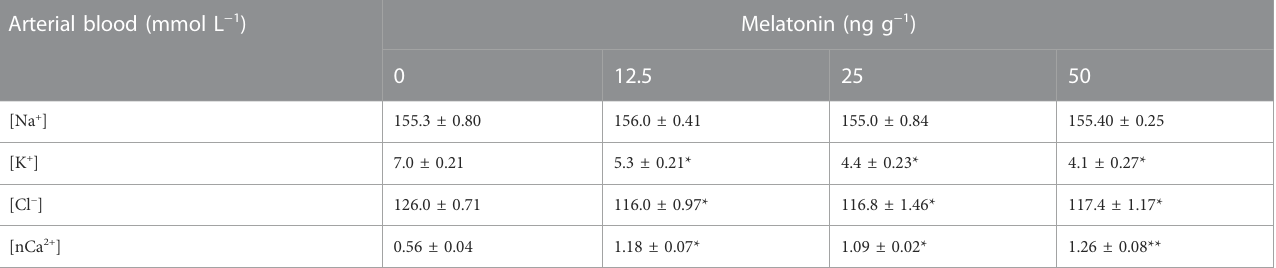
TABLE 2 Dose-responsive in vivo action of melatonin (0, 12.5, 25, 50 ng g − 1 ) injection for 30 min on blood ions in non-stressed A. testudineus . Arterial blood (mmol L − 1